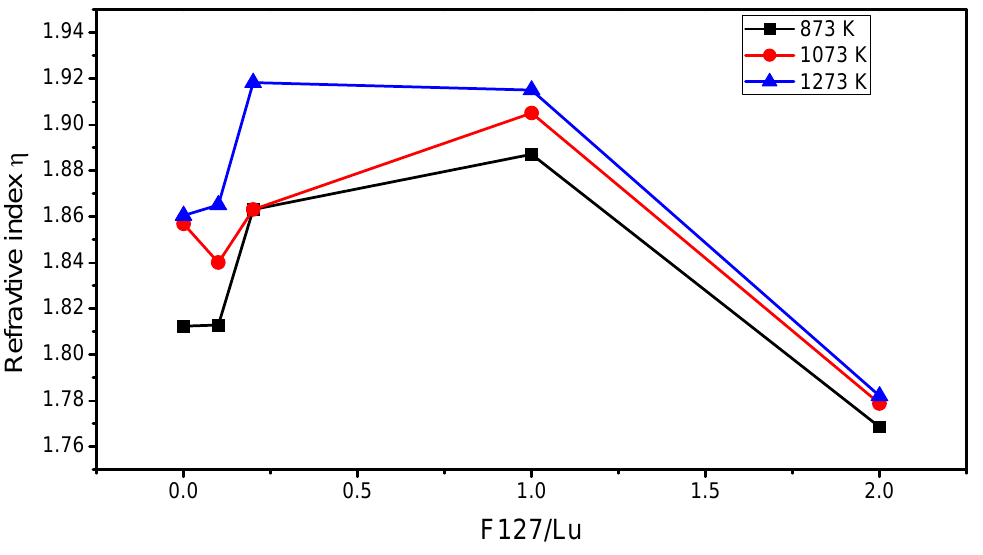
Figure 7. Evolution of refractive index at 633 nm of Lu as a function of annealing temperature and F127/Lu molar